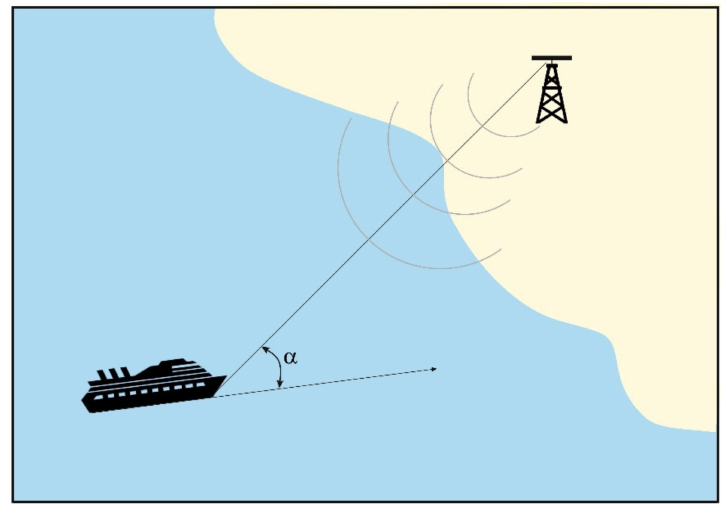
Figure 2. Graphical interpretation of an